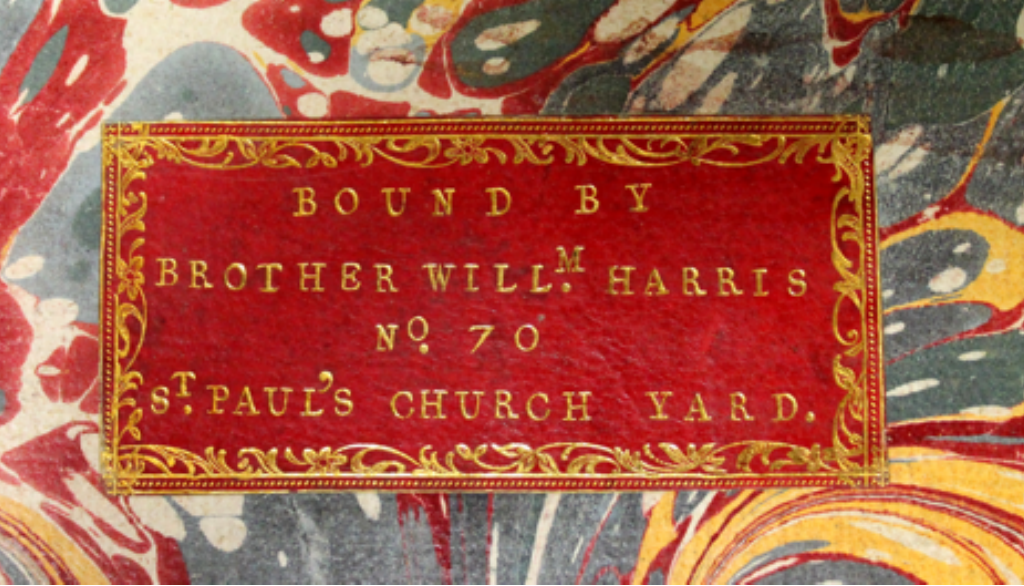
Fig. 28. Lettering piece on the inside of The Constitutions of the ... Masons, [1767-1776]. Copyright and reproduced by permission of the Museum of Freemasonry, London.